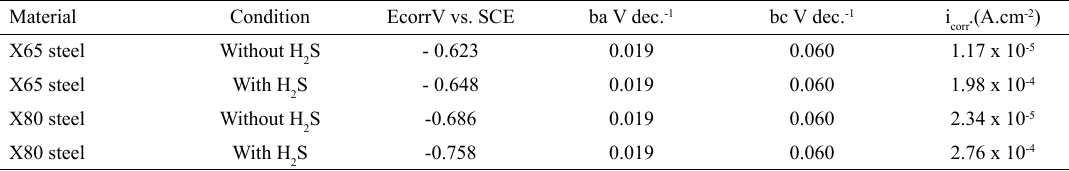
Table 3. Table with information extracted from the polarization curves of Figure 7. Procedure 1.